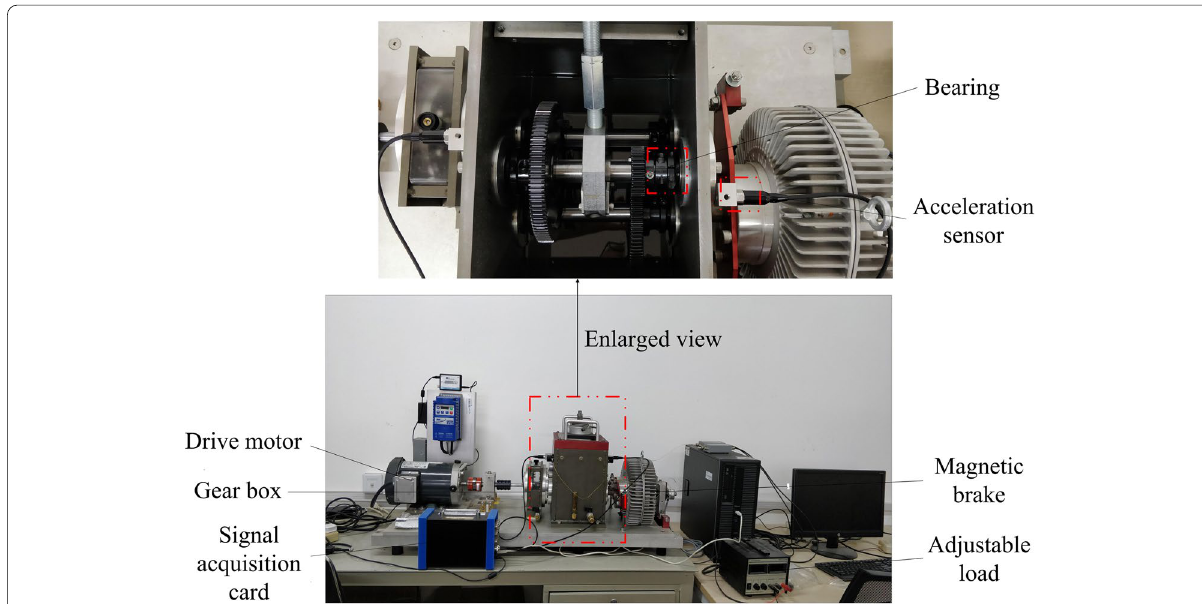
Fig. 5 Drivetrain diagnostic simulator. The structure of the experimental platform was mainly composed of a drive motor, gear box, magnetic powder brake, and adjustable load